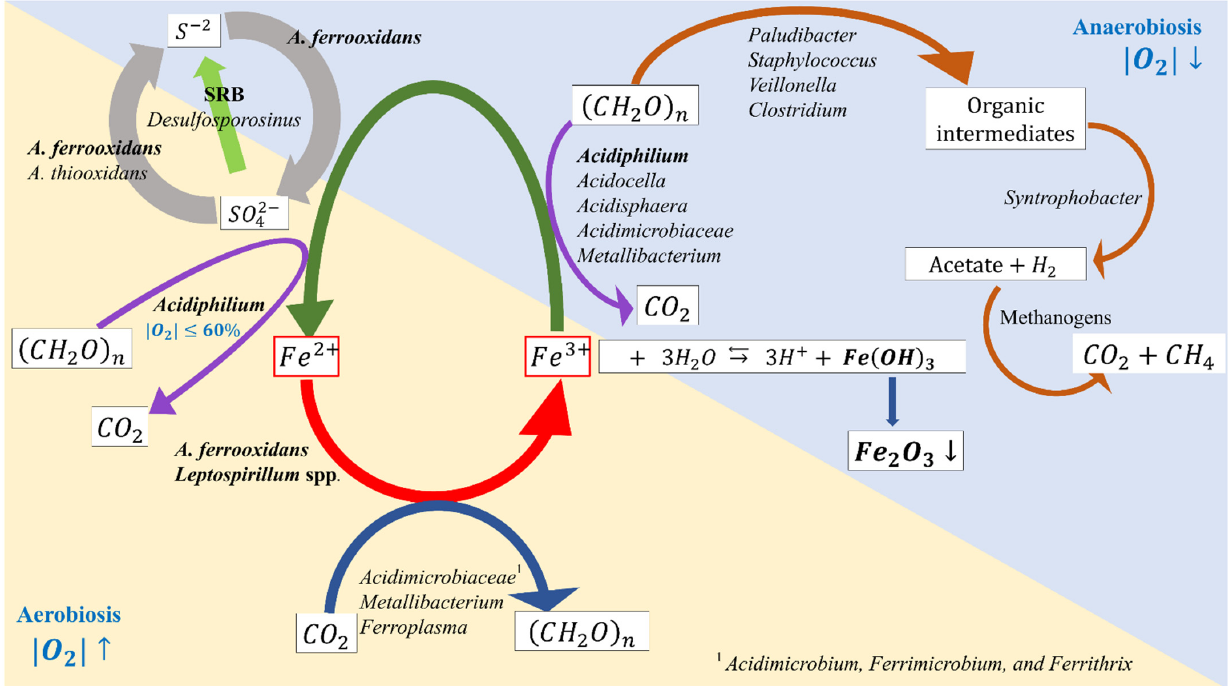
Figure 3. Geomicrobiological model of the role of microorganisms in iron, sulfur and carbon cycling in the natural acidic drainage environment of The Tinto River. A. ferroxidans, Acidiphilium , and Leptospirillum spp., represented in bold type are the microorganisms with the highest relative cell density in the model. Iron-oxidizing microorganisms participate in ferrous iron oxidation to ferric (blue and red arrow) represented by: A. ferrooxidans , Leptospirillum spp. Acidimicrobiaceae ( Acidimicrobium , Ferrimicrobium , and Ferrithrix ), Metallibacterium , and Ferroplasma . Iron-reducing microorganisms contribute towards ferric iron reduction to ferrous (purple arrow) and include: Acidiphilium , Acidisphaera , Acidimicrobiaceae , and Metallibacterium . SRB: sulfur-reducing microorganisms (e.g., Desulfosporosinus ) participate in the sulfur reduction metabolic pathway. Sulfur-oxidizing microorganisms are represented by: A. ferrooxidans and A. thiooxidans . Microorganisms participating in microbial fermentation and respiration as part of carbon cycle (brown arrows) include: Paludibacter , Staphylococcus , Veillonella , Clostridium , Synthrobacter , and methanogens. Image adapted with permission from [70], published by Elsevier Inc, 2019.